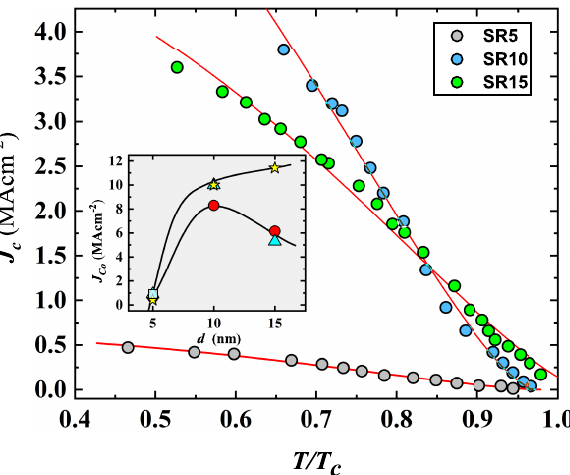
Figure 4. Current density as a function of the temperature, normalized to T c , for the whole set of NbN films deposited on the Al 2 O 3 r-cut substrate. Lines are the result of the least-squares fitting by the Ginzburg–Landau equation (see ref. [31]). Inset: thickness dependence of the critical current density at zero temperature, J c 0 , for NbN films deposited on Al 2 O 3 r-cut (circles), Al 2 O 3 c-cut (triangles), MgO (stars), SiO 2